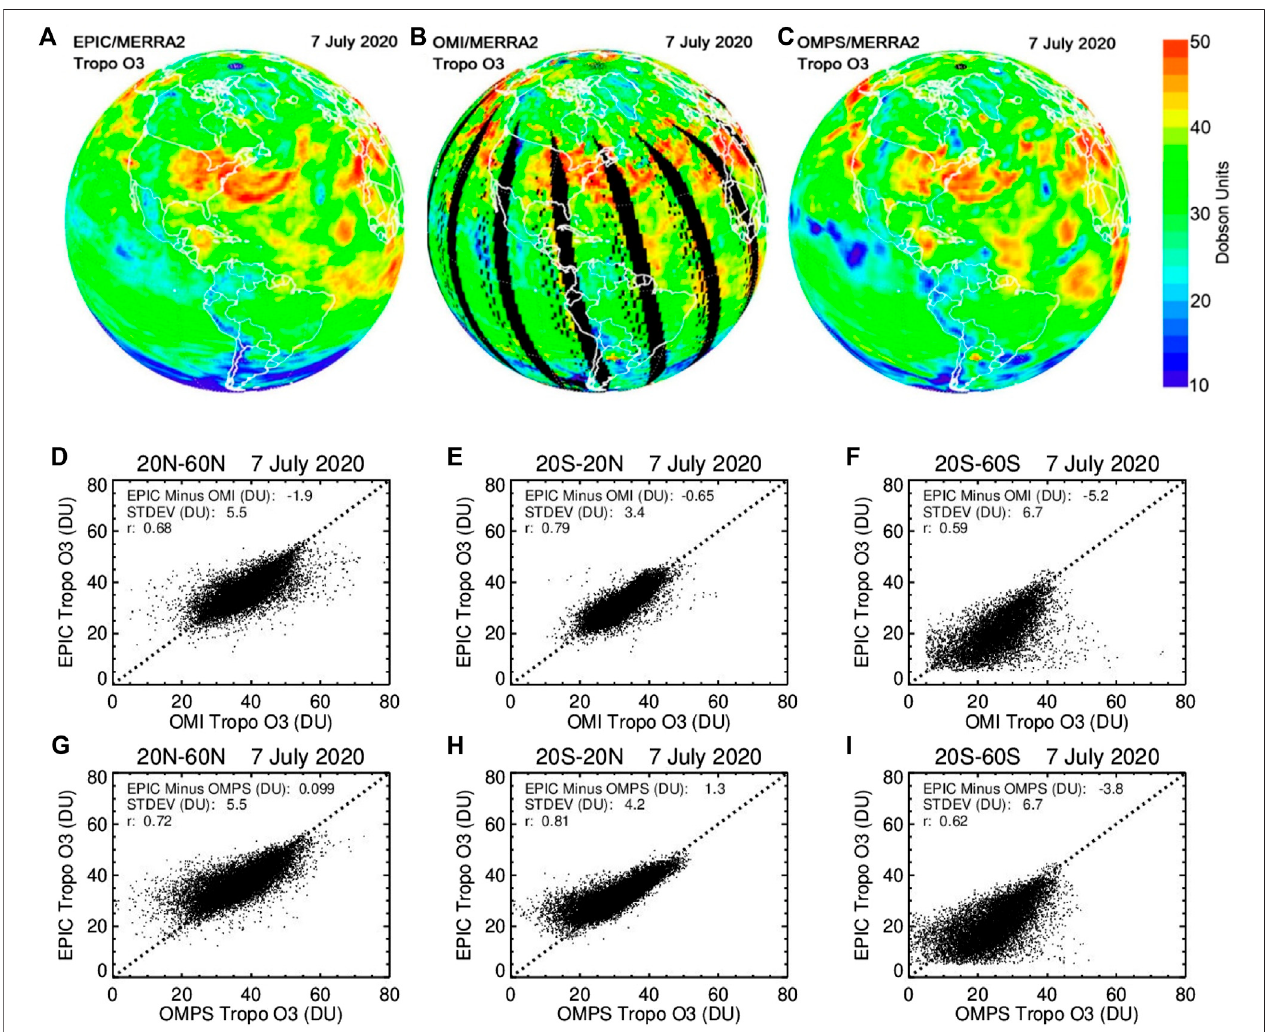
FIGURE 13 | The three upper color panels show daily maps of TCO (in DU) derived from EPIC (A) , OMI (B) and OMPS (C) on July 7, 2020. The lower panels (D – I) show scatter plotsofEPIC TCOagainstcoincidentOMI(center row, D – F )and OMPS(lower row, (G – I) ).Thescatter plotsareshownfor threewidelatitude zones: 20 ° N- 60 ° N(leftcolumn, D,G ),20 ° S-20 ° N(centercolumn, E,H )and20 ° S-60 ° S(rightcolumn, F,I ).Themeandifferencesandcorrespondingstandarddeviations(bothinDU)are shown in each panel along with correlation coef fi cients.